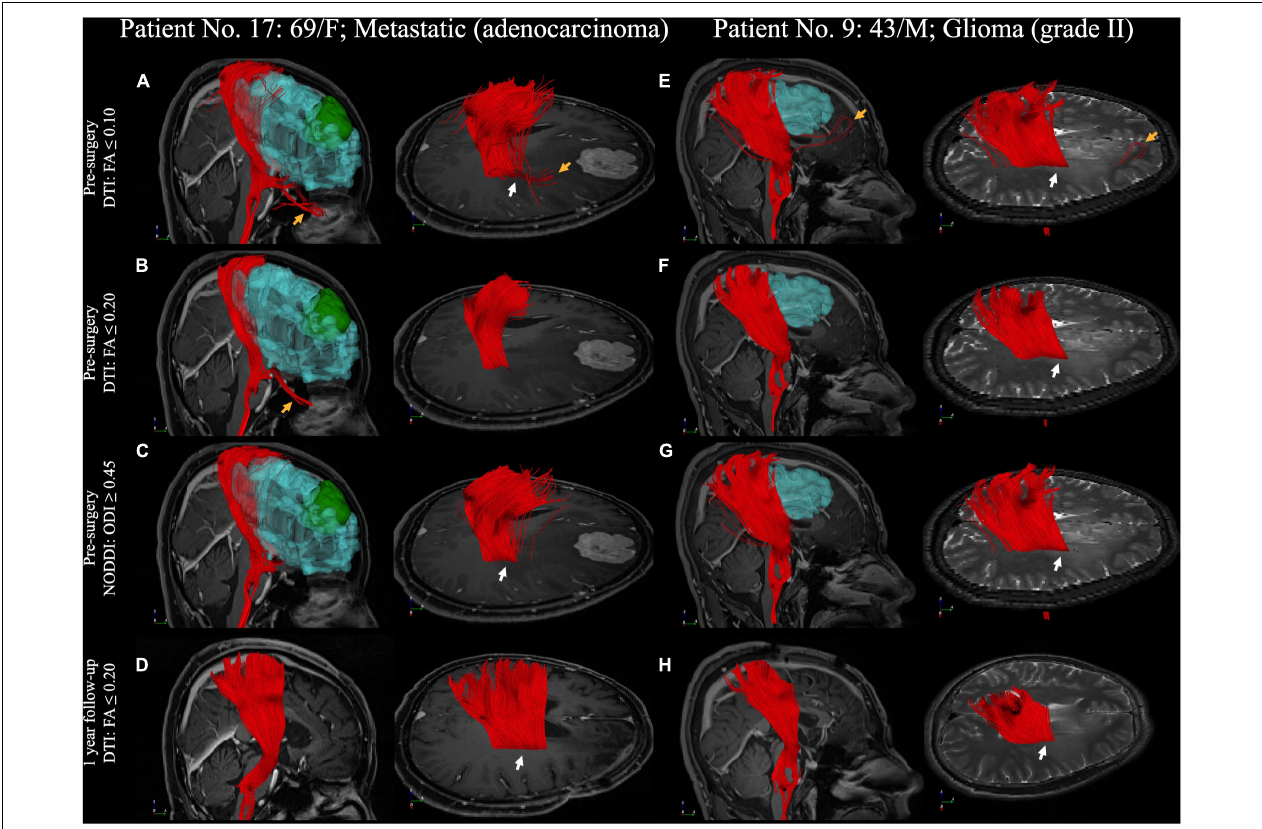
FIGURE 7 | A comparison between DTI and NODDI-derived CST reconstruction with 1-year follow-up. (A–D) Patient No. 17, a 69-year-old woman with an adenocarcinoma metastatic in the right frontal lobe. (E–H) Patient No. 9, a 43-year-old man with WHO grade II glioma in right parietal lobe. CST reconstruction in DTI and NODDI-derived tractography in pre-surgery and 1 year after tumor resection. White arrow indicated the fiber tracts in the peritumoral edema. DTI, diffusion tensor imaging; FA, fractional anisotropy; NODDI, neurite orientation dispersion and density imaging; CST, corticospinal tract; WHO, World Health Organization and ODI, orientation dispersion